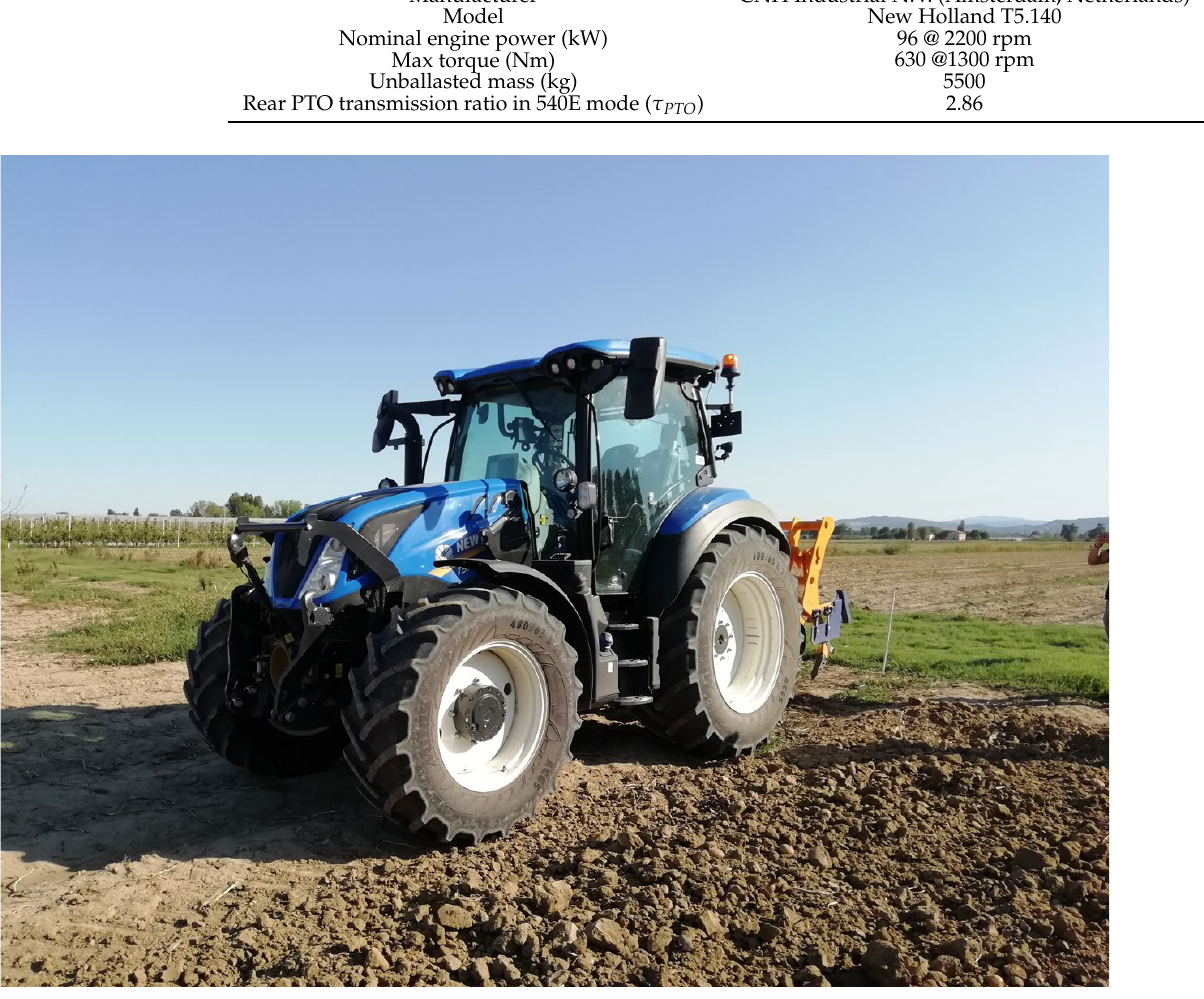
Figure 2. Picture of the New Holland T5.140 (CNH Industrial N.V., Amsterdam, Netherlands) during the tests with the Rotoripper. Table 2. Main specifications of the tractor used for the tests claimed by the manufacturer.